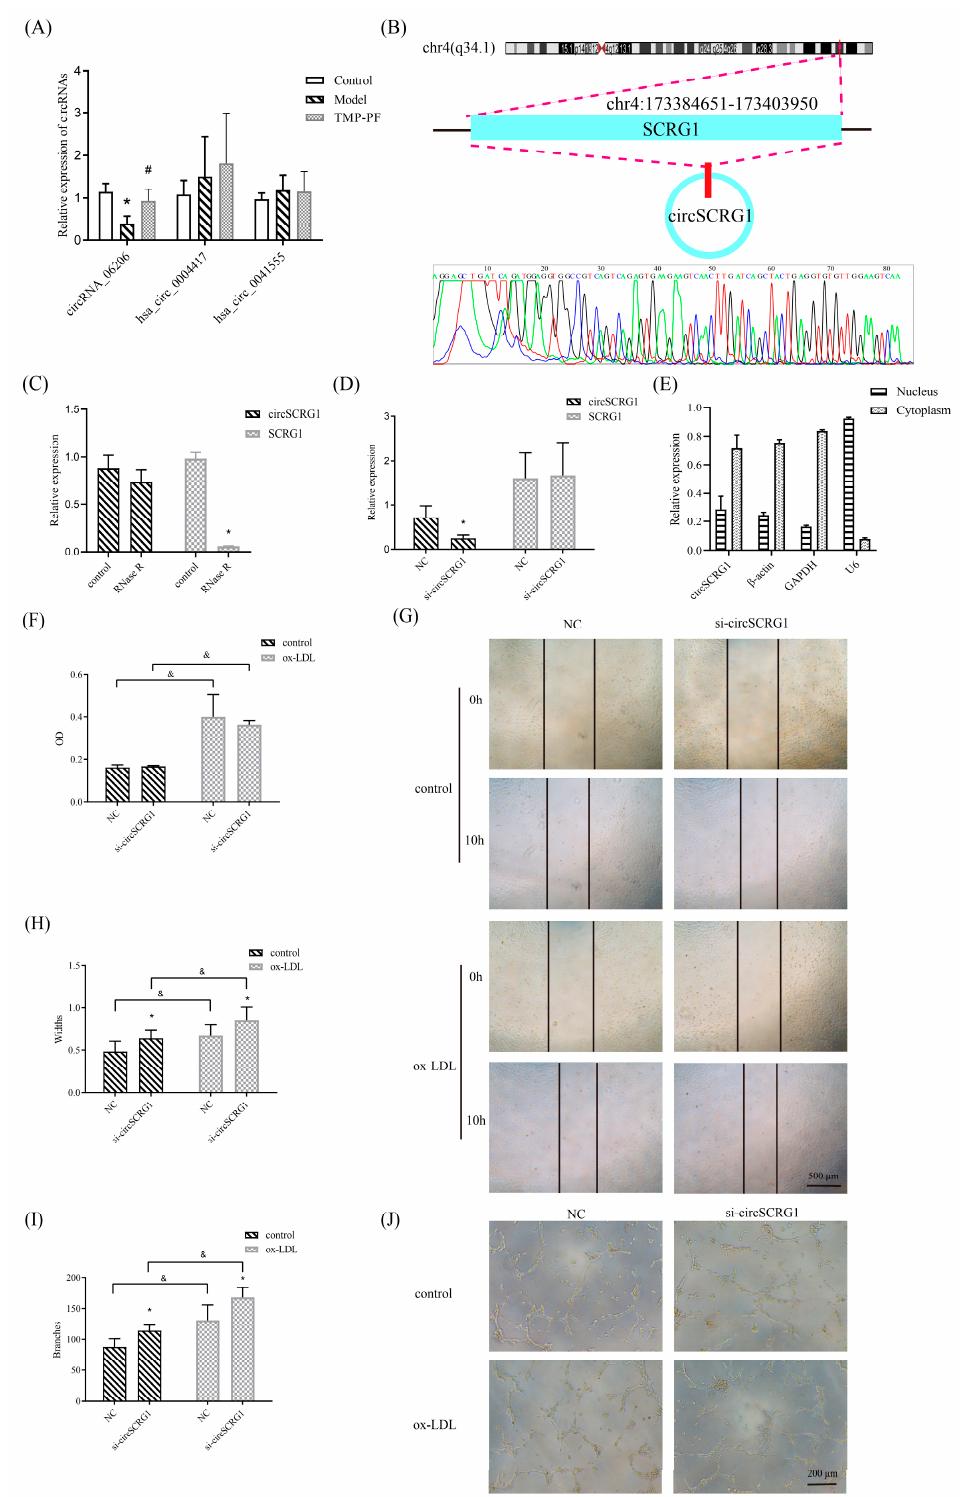
Figure 2. Verification of a target circRNA and its anti-angiogenic effects in oxidized low-density lipoprotein (ox-LDL)-induced human umbilical vein endothelial cells (HUVECs). ( A ) HUVECs were induced with 20 μ g/mL ox-LDLs for 24 h to establish a model and then treated with TMP-PF (1 μ mol/L TMP combined with 10 μ mol/L PF) for 24 h. The relative expression levels of circRNA_06206, hsa_circ_0004417, and hsa_circ_0041555 in HUVECs were evaluated by real-time